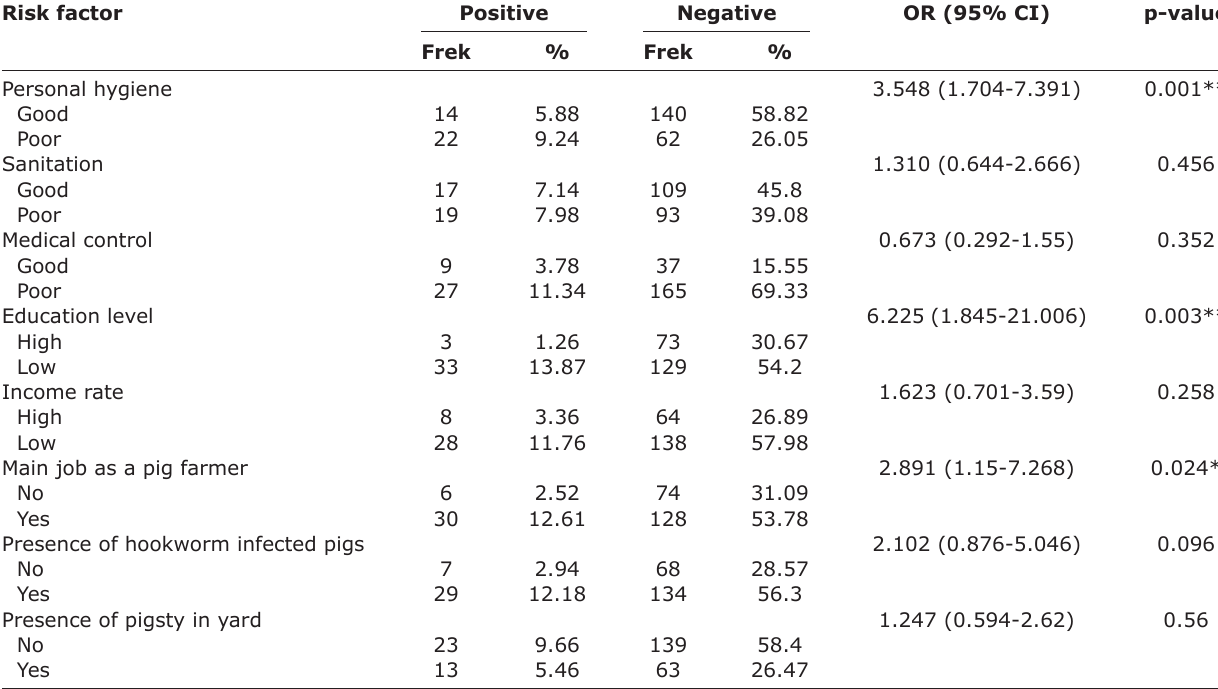
Table-5: Risk factor of hookworm infection in traditional pig farmers in Bali. Risk factor